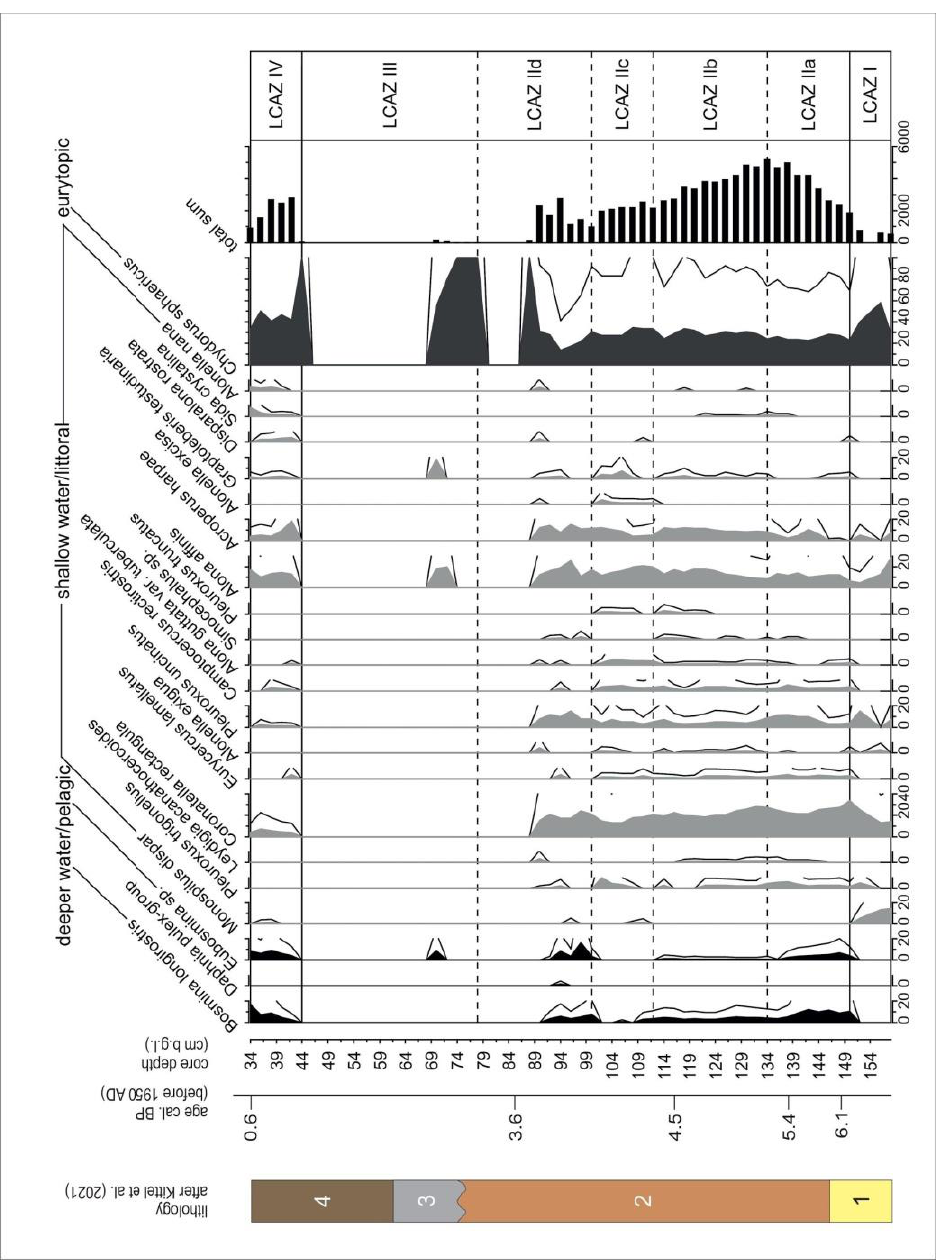
Figure 3. Cladocera stratigraphic diagram presenting the classification of taxa according to lake depth preferences. Exaggeration is with a three times multiplier. Lithology: 1—sand and gravel with organic mud and plant detritus; 2—coarse detritus gyttja; 3—carbonate sandy organic mud; 4—peaty organic mud with sandy admixtures.